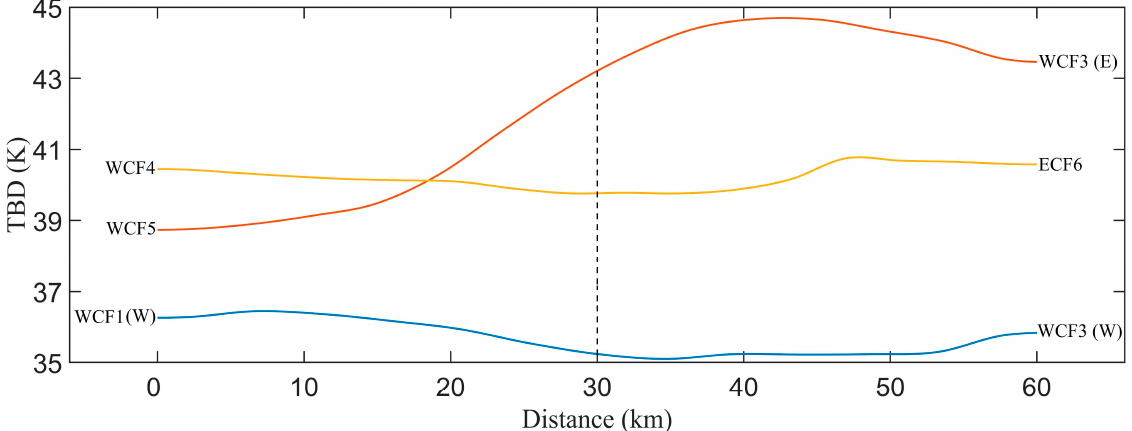
Figure 11. The profiles of the 37-GHz TBD from the western WCF1 (WCF1 (W)) to the western WCF3 (WCF3 (W)), from the WCF4 unit to the ECF6 unit, and from the WCF5 unit to the eastern WCF3 (WCF3 (E)). The black dashed line represents the boundary between the basaltic units mapped by Kramer et al. [2]. The locations of the profiles are shown in Figure 6d (orange lines).